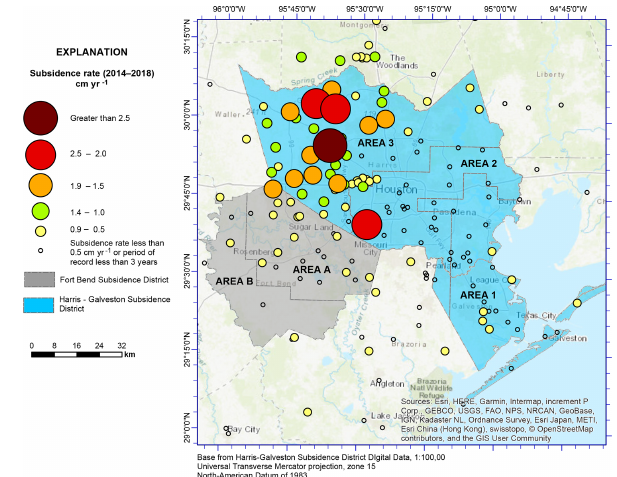
Figure 2. Annual rate of ellipsoid height estimated from avail- able GPS data measured at monitoring location within the Hous- ton Region, 2014–2018. (Thompson et al., 2019, base courtesy of © ESRI).